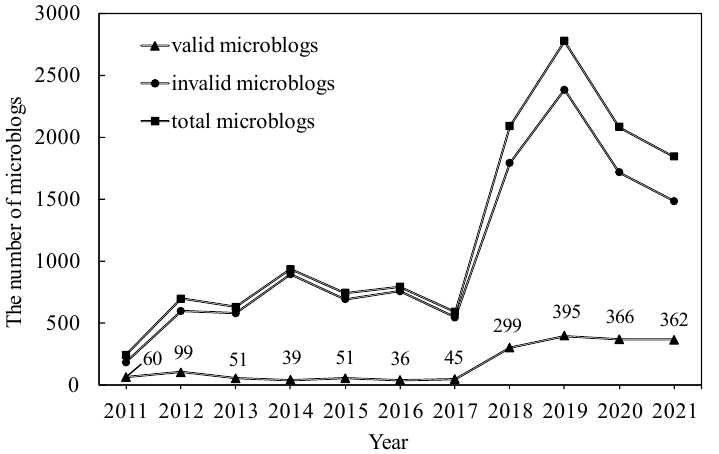
Figure A1. Weibo data with the keyword “ pollen allergy ” in Beijing during 2011 – 2021. The sharp increase in Weibo data in 2018 is because the mobile side of Weibo began to be widely popular in that year, with mobile active users accounting for 93% of the total active users, which is sourced from the Weibo Data Center. Weibo 2018 User Development Report [EB/0 L], 2019 – 03-15.